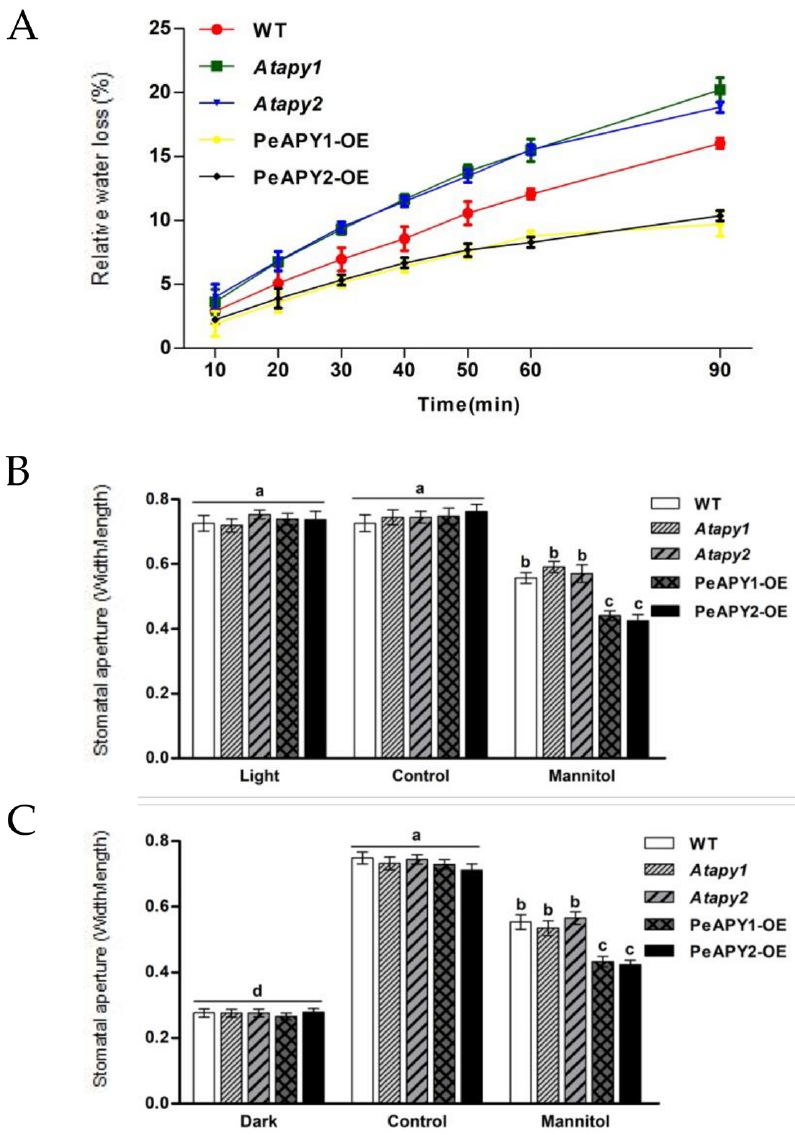
Figure 1. The relative water loss of leaves upon air exposure and the effect of mannitol on stomatal aperture in wild-type (WT), Arabidopsis loss-of-function mutants for APY1 and APY2 ( Atapy1 and Atapy2 ) and transgenic lines of PeAPY1 and PeAPY2 (PeAPY1-OE and PeAPY2-OE). ( A ) Leaves were excised from three-week-old seedlings and subjected to dehydration treatment in air under a light intensity of 150 mmol m − 2 s − 1 . Water loss from the leaf surface was regularly measured during the period of 90 min air exposure. ( B , C ) Leaves isolated from three-week-old seedlings were incubated in MES-Tris buffer containing 50 mM KCl and 10 mM MES-Tris (pH 6.15) for 2 h in light (150 µ mol m − 2 s − 1 ) ( B ) or in darkness ( C ). Thereafter, leaves were exposed to 0 (control) or 200 mM mannitol for 2 h in cool light (150 µ mol m − 2 s − 1 ). Stomatal aperture was measured in continuously illuminated leaves ( B ) and dark-adapted plants transferred to light ( C ), respectively. Each column is the mean of three independent experiments, and error bars represent SE. Columns labeled with different letters, a, b, c and d, showed a significant difference at p < 0.05 between treatments and genotypes under conditions of continuous light ( B ) or dark-adapted leaves transferred to light ( C